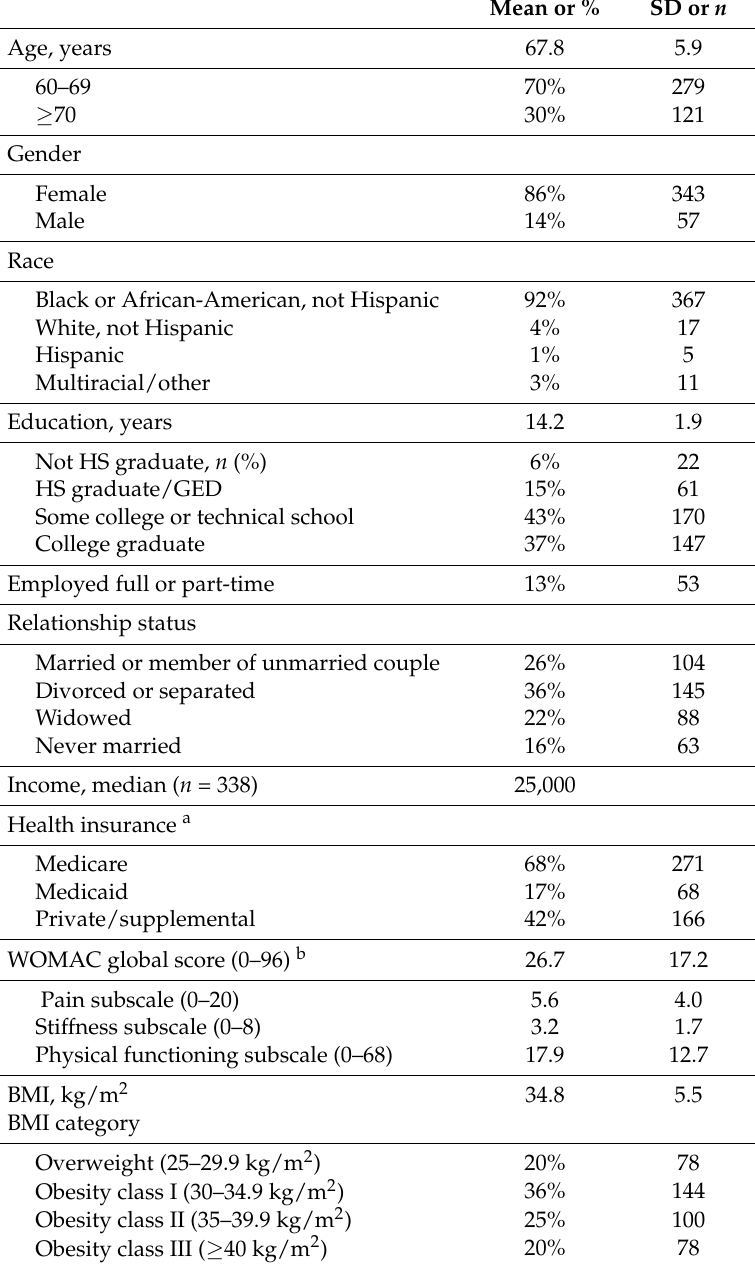
Table 1. Characteristics of urban overweight and obese primarily African American older adults with osteoarthritis ( n =